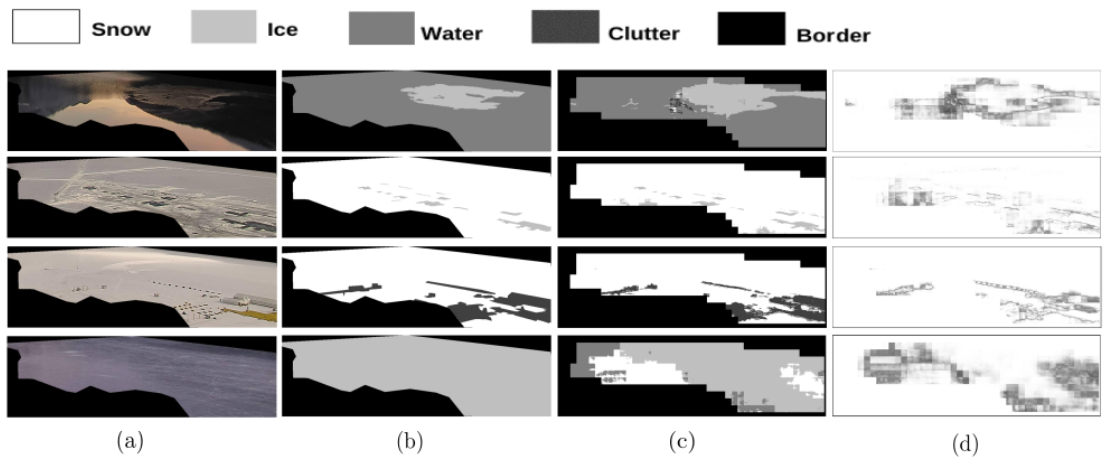
Figure 6. Semantic Segmentations for Cam0. (a): RGB input; (b): manual segmentations; (c): predicted segmentations; (d): reliability maps.